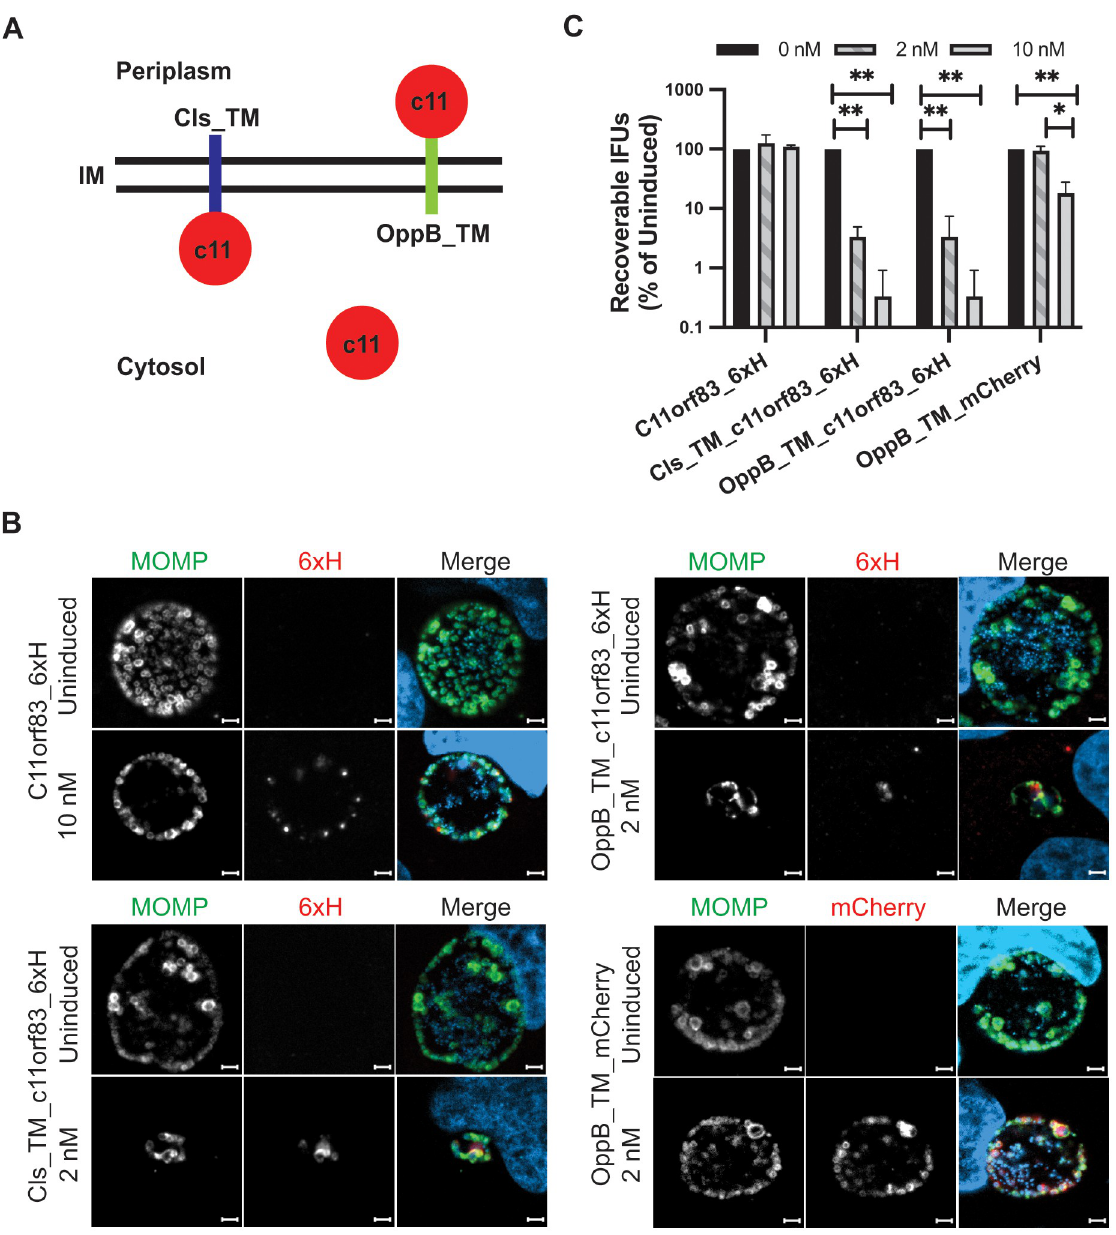
Fig 5. Effect of overexpressing the cardiolipin binding protein, C11orf83, on chlamydial growth and morphology. (A) Schematic of the expected localization of each C11orf83 (c11) construct when expressed in chlamydiae. IM = inner membrane; Cls_TM = first 25 residues of Cls fused to c11; OppB_TM = first TM domain of E . coli OppB fused to c11 (or mCherry). (B) Cells were infected with C . trachomatis L2 transformants carrying anhydrotetracycline (aTc) inducible plasmids and encoding the indicated constructs. Expression of each was induced or not at 8hpi with 2 or 10nM aTc as indicated, and cells were fixed and processed for immunofluorescence at 24hpi as described in the legend to S3 Fig. Images were acquired on a Zeiss AxioImager.Z2 equipped with an Apotome2 using a 100X lens objective. Images are representative of at least three independent experiments. Scalebar = 2 μ m (C) Cells were infected with the indicated transformants and processed as described in the legend to S3 Fig to quantify IFU production during the primary infection. For each transformant, the uninduced values were arbitrarily set to 100%, and the effect of overexpression at either 2nM or 10nM aTc when added at 4hpi is expressed as a percentage of the uninduced control. Samples were collected at 24hpi. Data are the average of three independent experiments performed in triplicate. � = p < 0.05; �� = p <